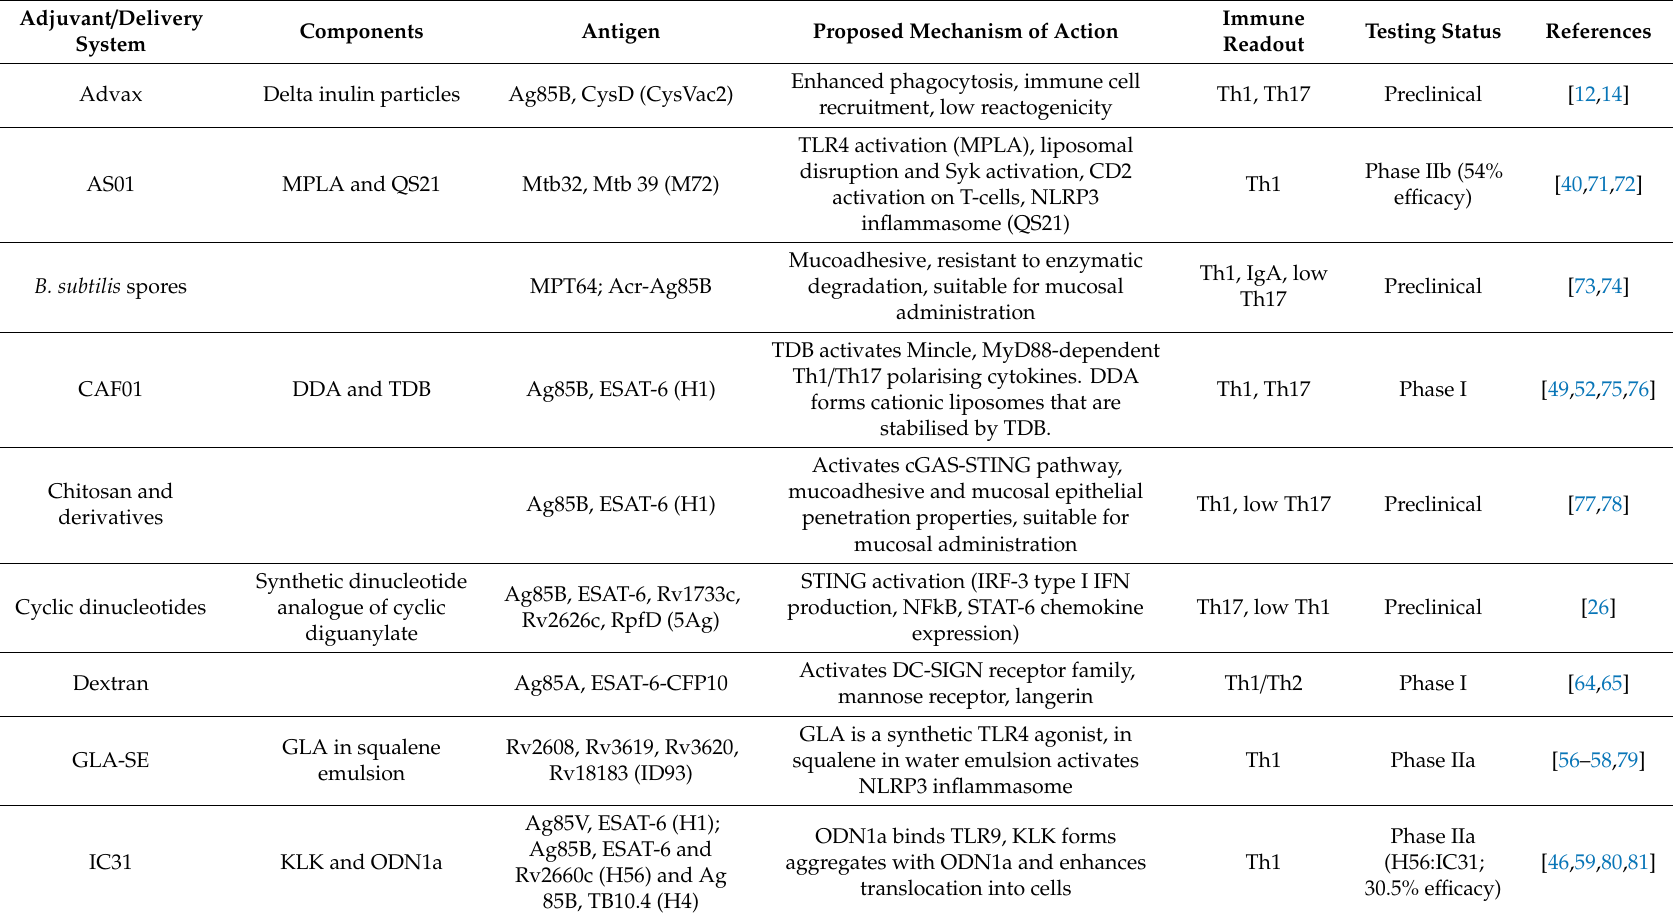
Table 1. Summary of adjuvant strategies in human TB vaccine clinical trials or in preclinical animal testing. MPLA:3-O-desacyl-4 (cid:48) -monophosphoryl lipid A; DDA:dimethyldioctadecyl-ammonium; TDB:trehalose 6,6-dibehenate; GLA:glucopyranosyl lipid adjuvant; KLK:KLKL 5 KLK; TLR:toll-like